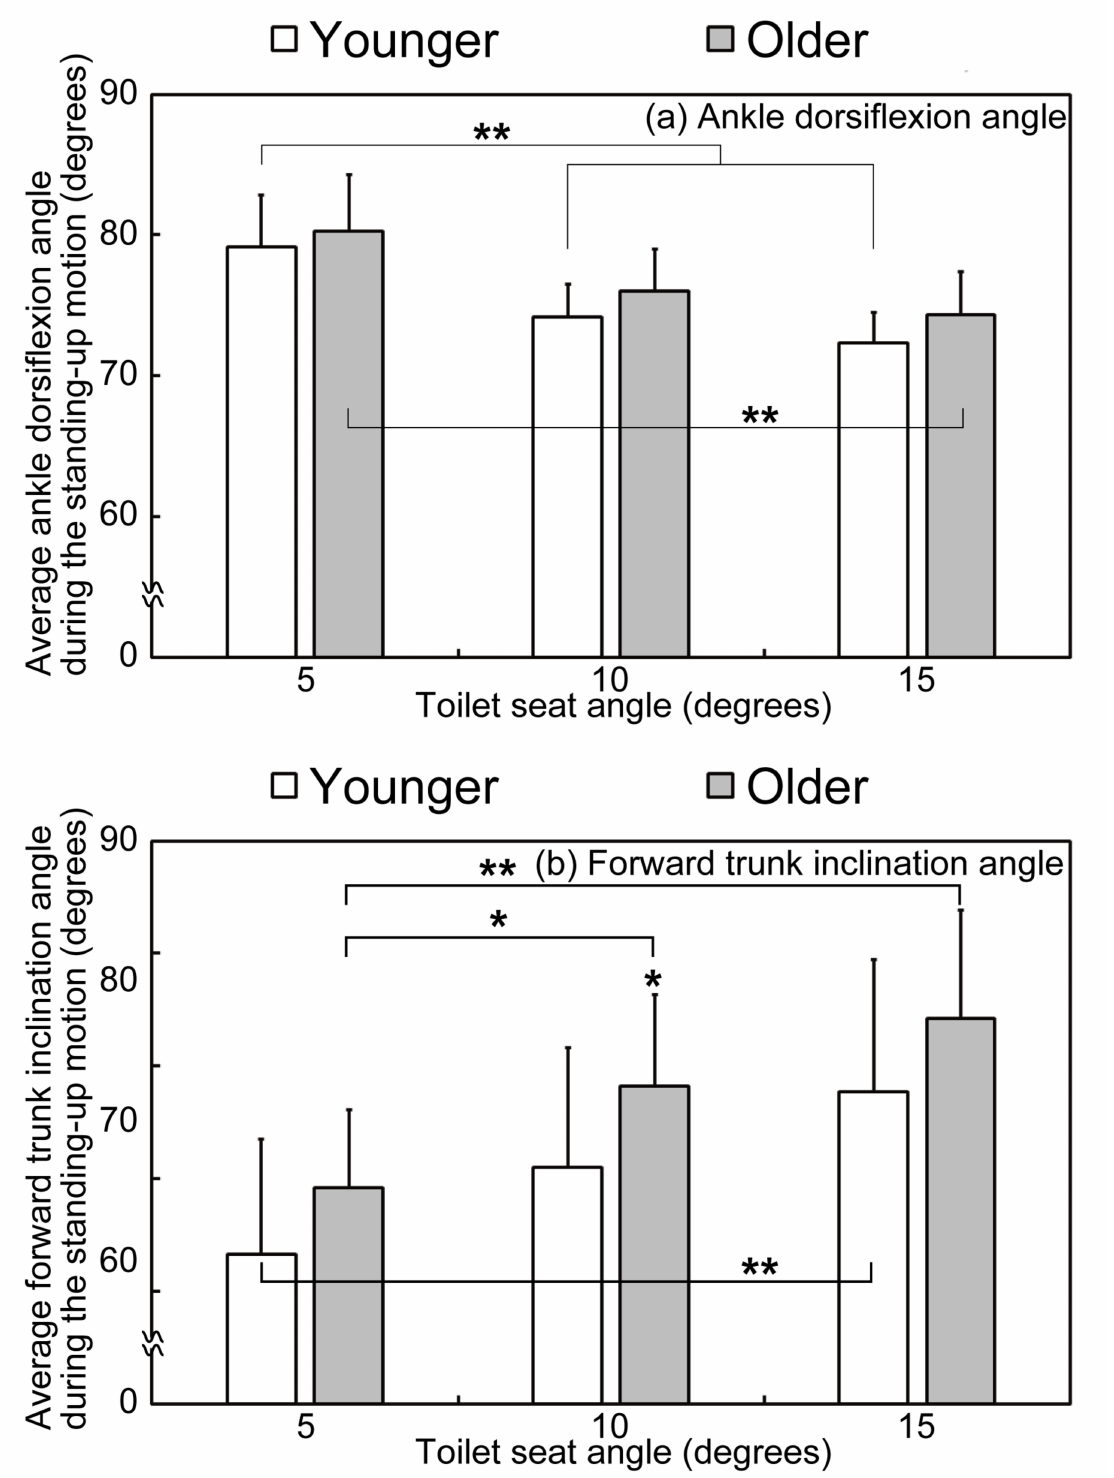
Figure 4. Average ankle dorsiflexion angle ( a ) and average forward trunk inclination angle ( b ) according to toilet seat angle. Vertical lines denote the standard error of the mean. Brackets indicate a statistically significant difference based on the Bonferroni test by toilet seat angle. Asterisks indicate statistically significant differences (based on the Bonferroni test) between younger and older participants. Bonferroni multiple comparison test (**) p < 0.01, (*) p <